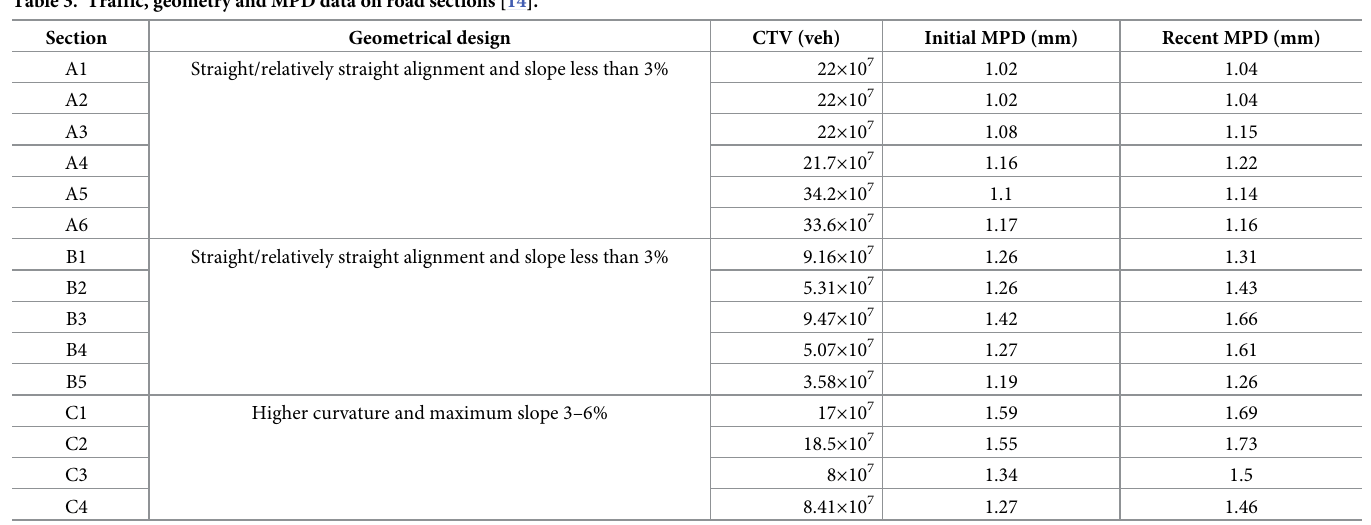
Table 3. Traffic, geometry and MPD data on road sections [14].